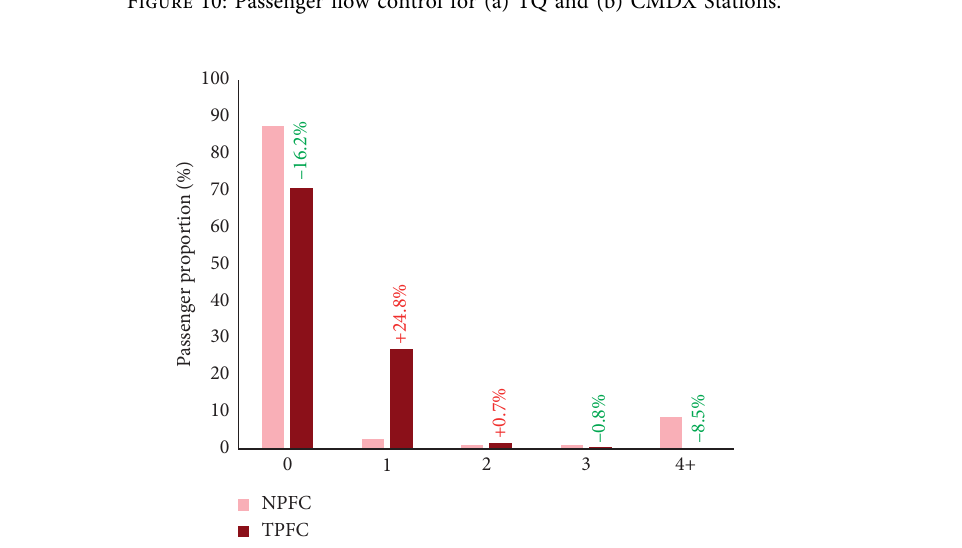
Figure 10: Passenger flow control for (a) TQ and (b) CMDX Stations.